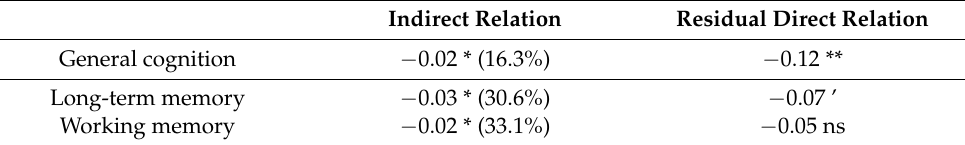
Table 2. Results of mediation